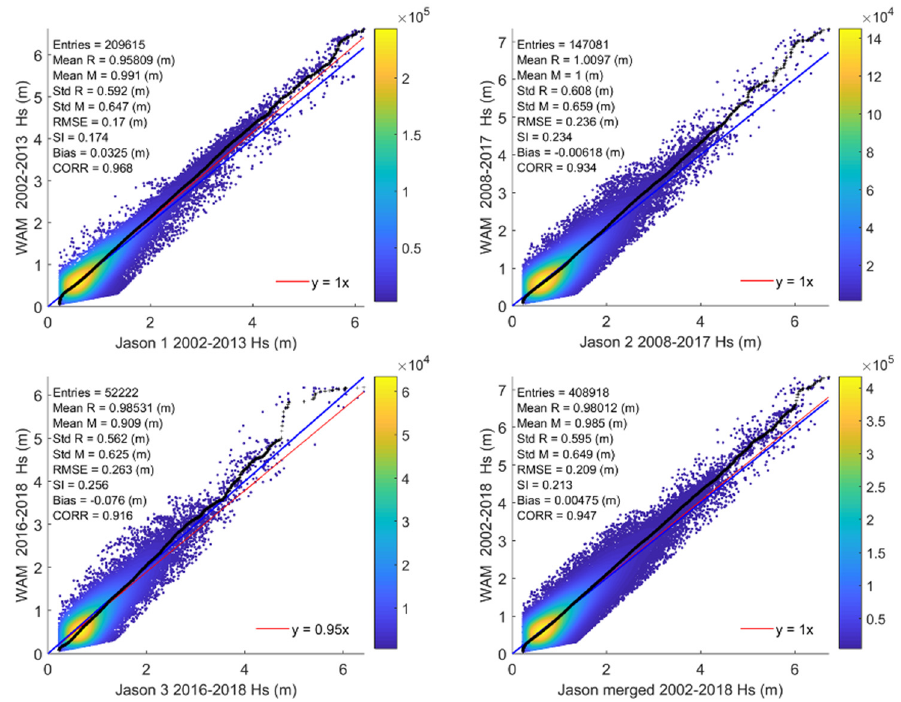
Figure 12. Scatter plots showing satellite measurements versus modelled significant wave heights (BS-WAV MY) for 2002–2013 (Jason-1), 2008–2017 (Jason-2), 2016–2018 (Jason-3), and 2002–2018 (all satellites merged). Additionally, the following are presented: the estimated bivariate probability density (colored area), the linear slope-fit regression of modelled and observed wave heights (red line), specific quantiles taken from the empirical cumulative density function (black line), and the diagonal (blue line). Summary statistics and skill scores are also included. R: reference (satellite) data, M: model data.